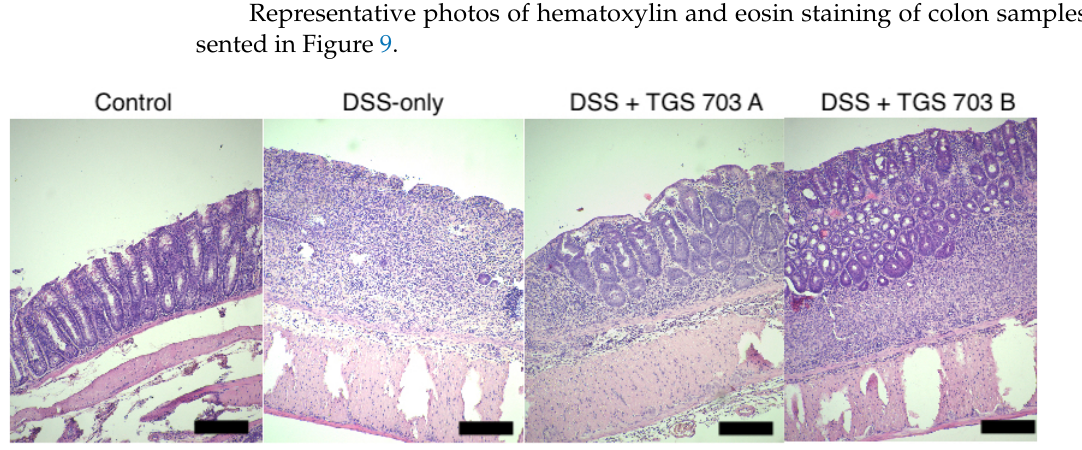
Figure 9. Representative photos of hematoxylin and eosin staining of colon samples. Scale bar = 100 μ m.